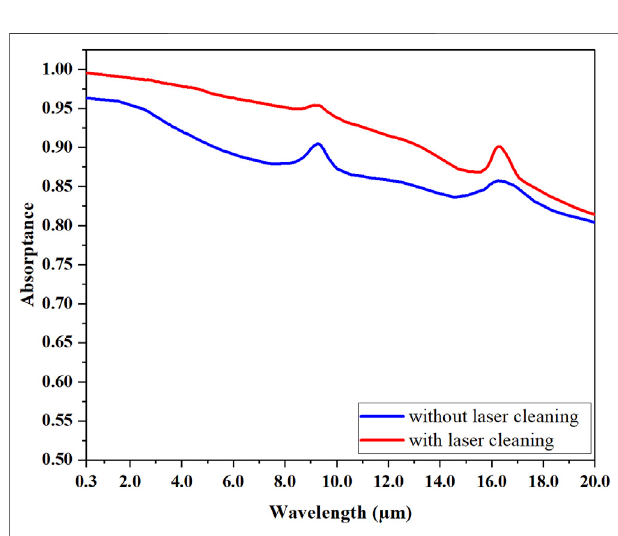
FIGURE 5 | Absorption curves of samples processed without laser cleaning and with laser